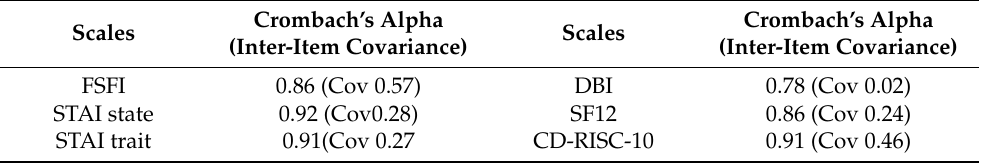
Table 3. Reliability measures for the